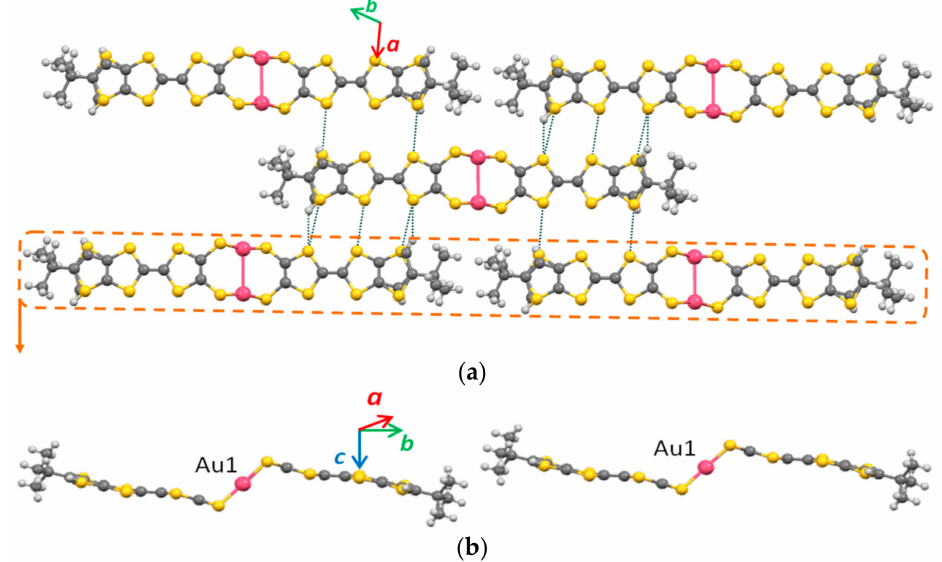
Figure 6. Anions Au1 in the crystal structure of ( n -Bu 4 N) 2 [Au 2 ( α -tbtdt) 2 ] ( 5 ): ( a ) View perpendicular to one anionic layer with side-by-side contacts; ( b ) view perpendicular to anionic